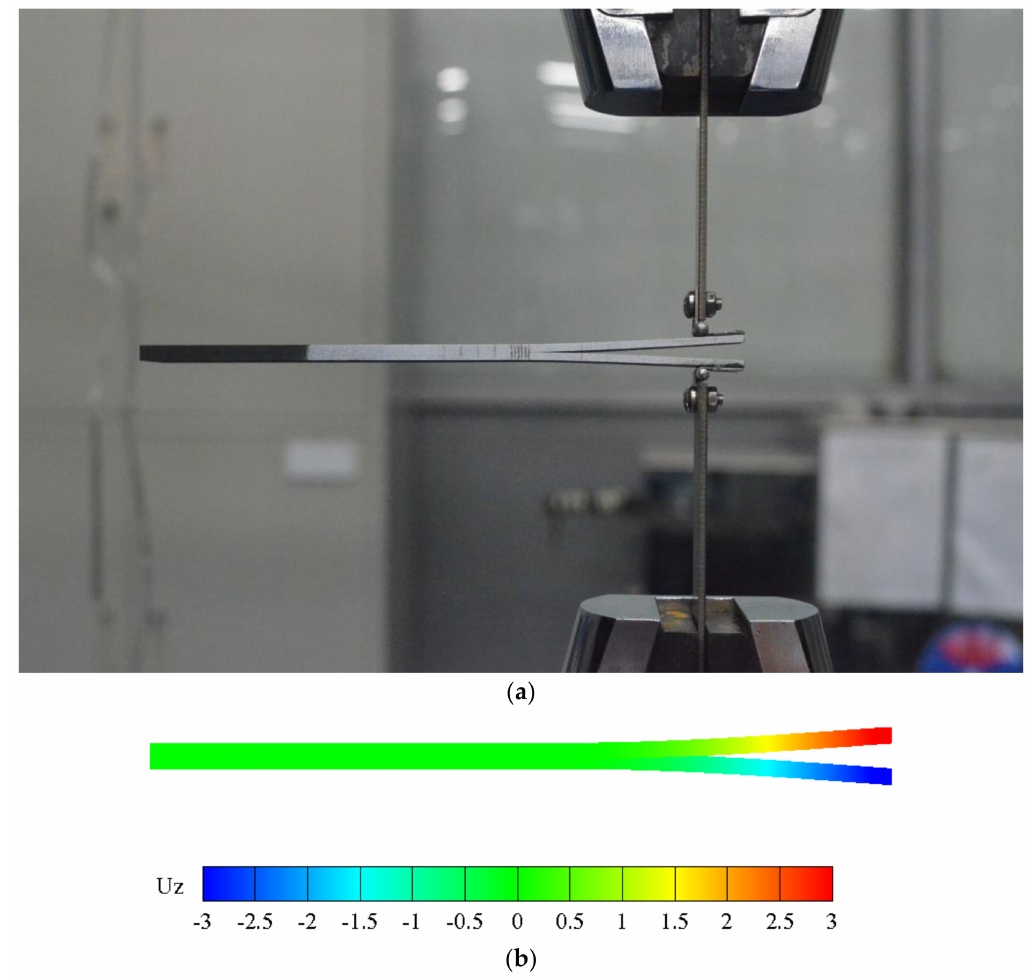
Figure 3. Carbon fiber-reinforced polymer (CFRP) double cantilever beam (DCB) test and two-dimensional PD modeling. ( a ) Double cantilever composite beam (DCB) test setup, ( b ) peridynamic (PD) modeling deformed displacement field in thickness direction